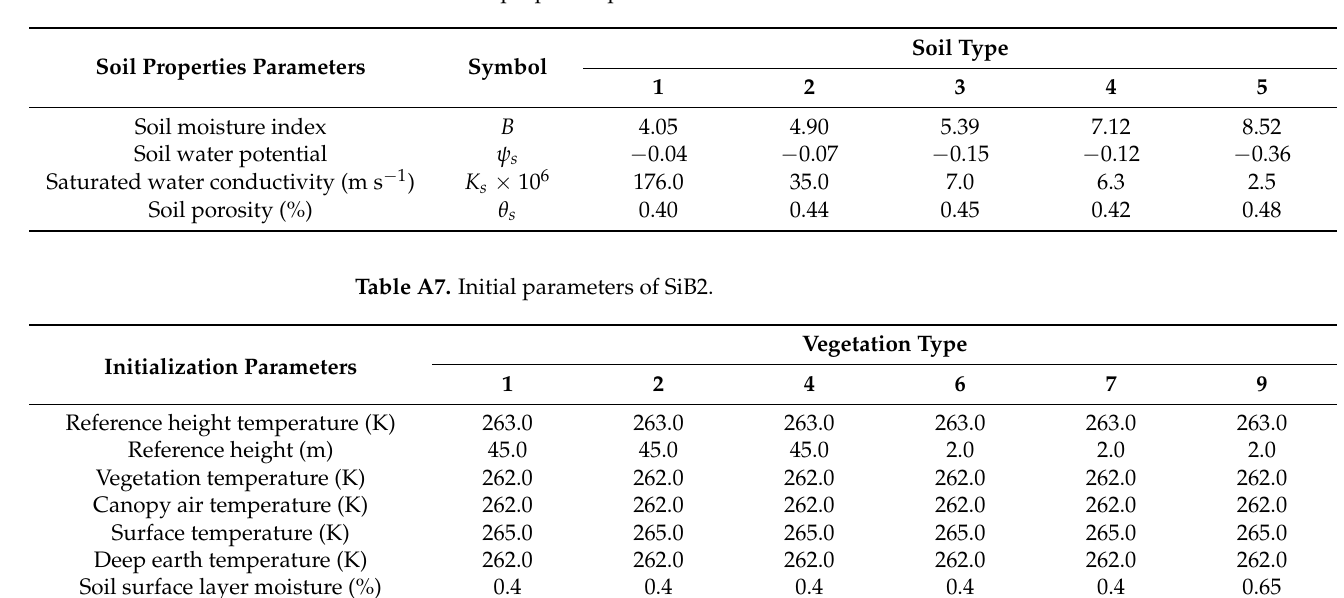
Table A6. Soil properties parameters.